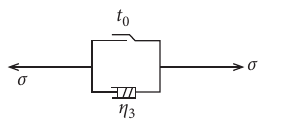
Figure 2: Diagram of a nonlinearly accelerated creep